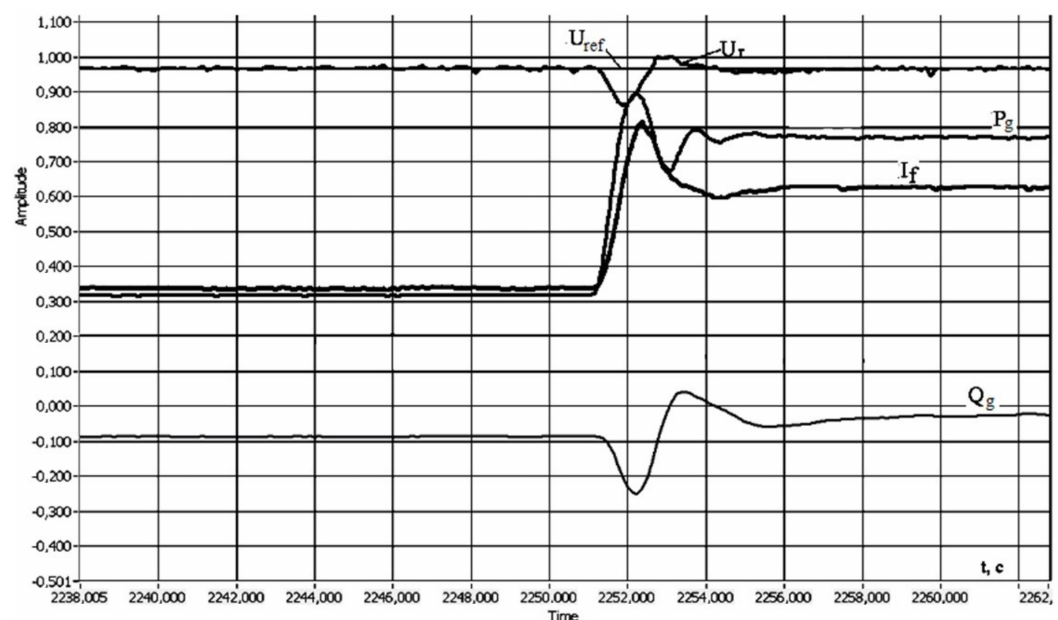
Figure 4. The mode of an abrupt loading of the generator by active